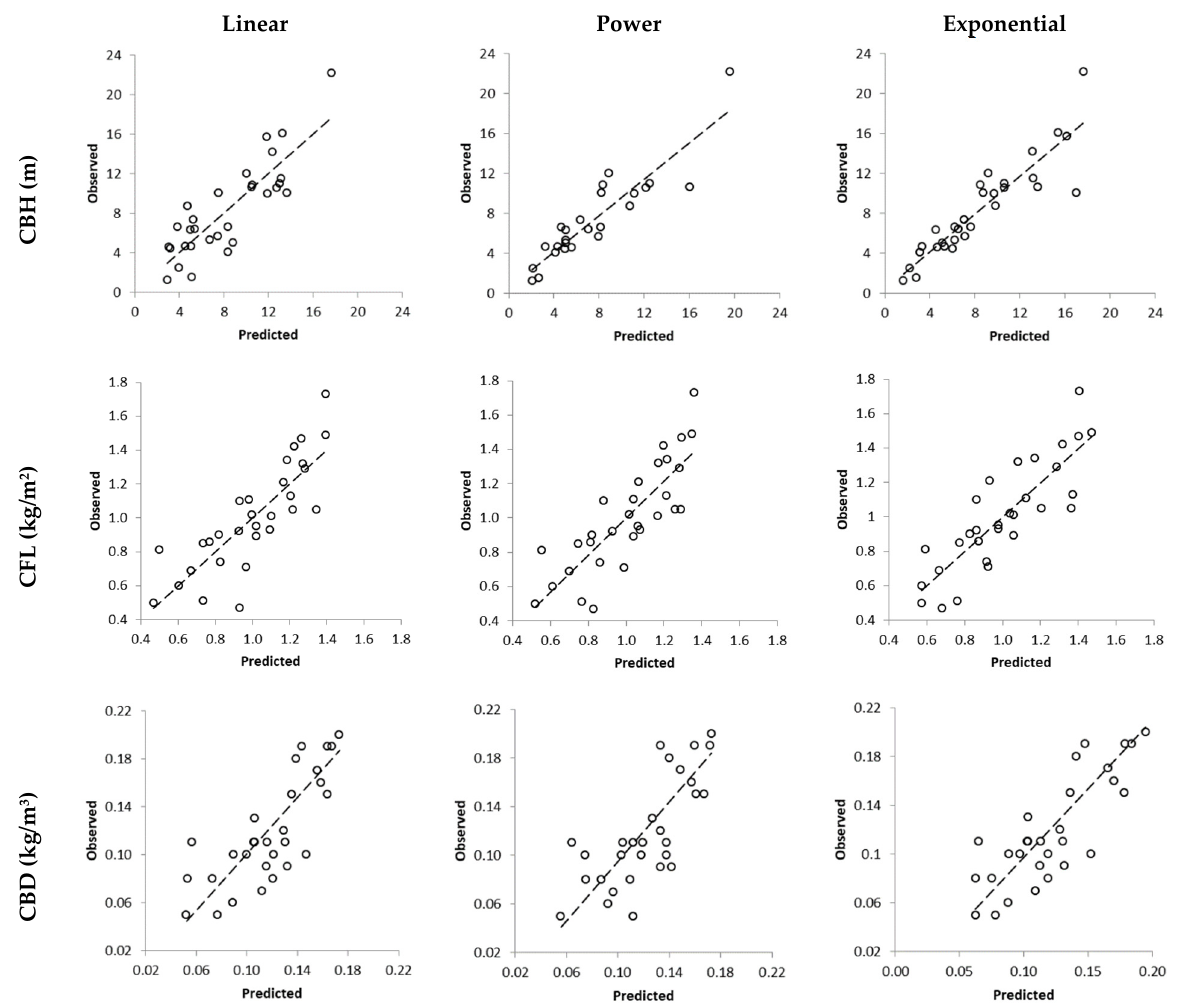
Figure 3. Observed vs. predicted values of canopy fuel attributes (CBH, canopy base height; CFL, canopy fuel load; CBD, canopy bulk density) resulting from model fitting with PNOA-2018 LiDAR data ( n = 30) for each formulation (linear, power, exponential). Least square trend line (dashed) is shown.